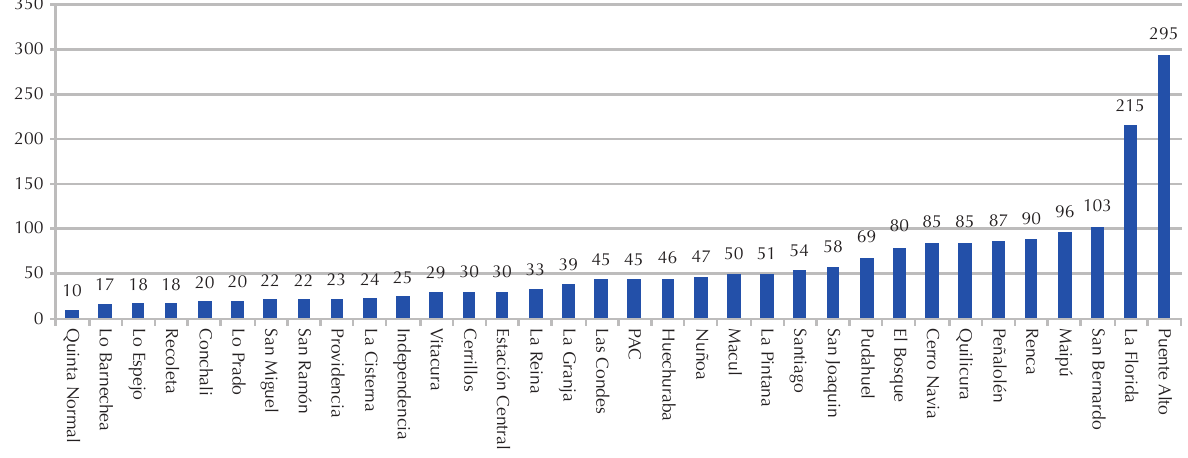
Figure 4: Number of outdoor gyms in each of the 37 districts of Santiago. Source: own